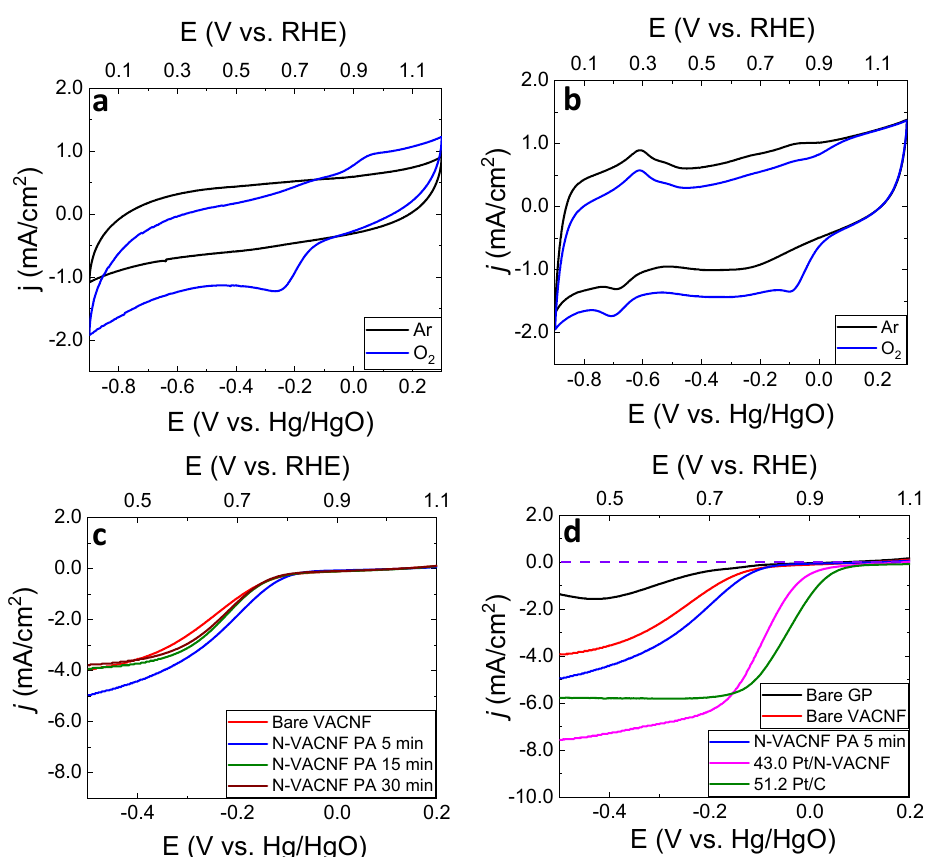
Figure 4. Cyclic voltammogram of ( a ) N-VACNF PA 5 min and ( b ) 43.0 Pt/N-VACNF recorded in Ar-saturated (black line) and O 2 -saturated (blue line) 0.10 M KOH solution at a scan rate of 50 mV/s; LSV curves recorded at a scan rate of 10 mV/s and a rotation speed of 1600 rpm ( c ) for various N doped VACNF catalysts and ( d ), bare graphite paper, bare VACNF, N-VACNF PA 5 min, Pt/N-VACNF (43.0 µg/cm 2 ), and Pt/C (51.2 µg/cm 2 ). The purple dash line marks the zero current den-sity.